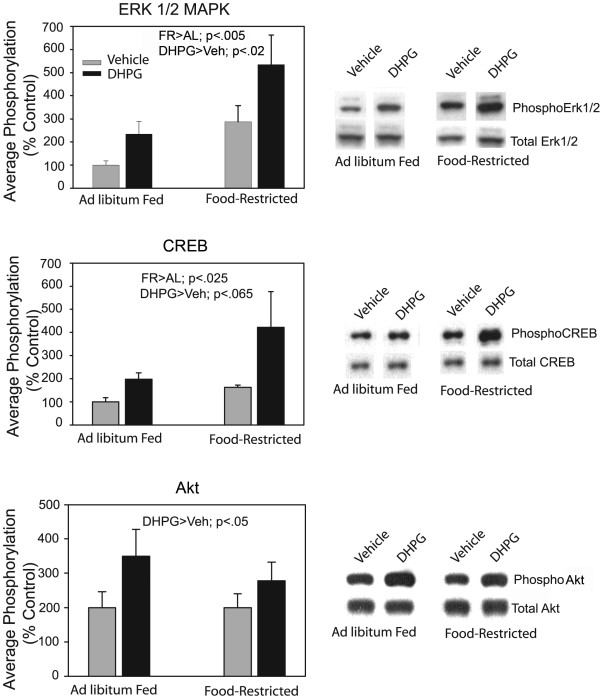
Effects of DHPG on activation of ERK1/2, CREB and Akt in Caudate-Putamen Ad libitum fed and food-restricted rats received i.c.v. injections of DHPG (500 nmol) or saline vehicle prior to sacrifice. Lysates were immunoblotted with anti-phospho ERK1/2 or anti-ERK1/2 (top), anti-phospho-CREB or anti-CREB (center), or anti-phospho-Akt or anti-Akt (bottom) antibodies. Following densitometry, intensities of bands corresponding to phosphorylated proteins were divided by intensities of the corresponding total protein bands to correct for small differences in protein loading. Results (mean ± S.E.M.) are expressed in comparison to the normalized control, which was defined as the ad libitum fed group injected with vehicle. Graphed results are displayed with representative immunoblots.